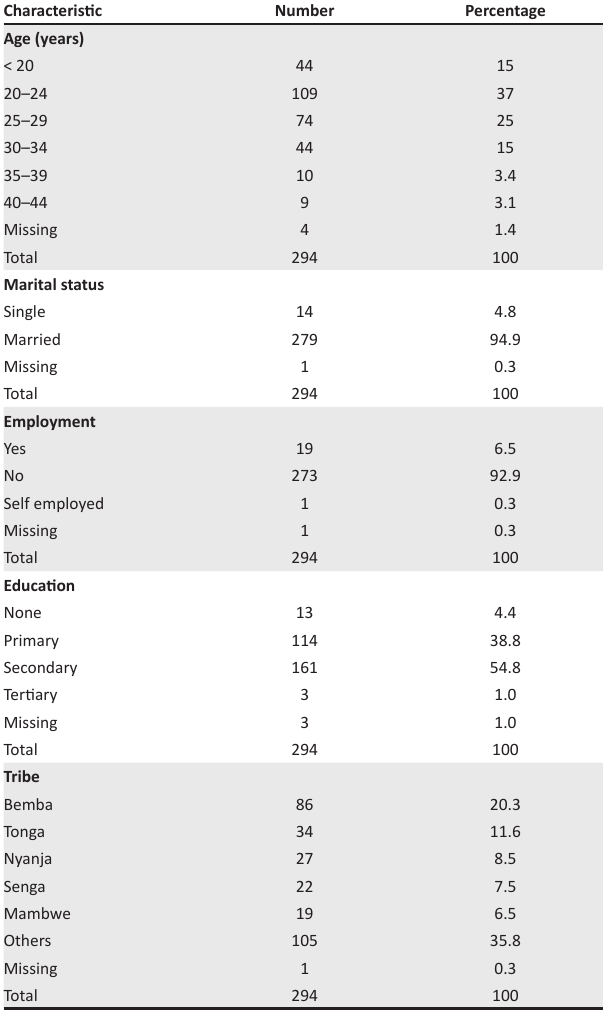
TABLE 1: Participants’ baseline characteristics ( n =